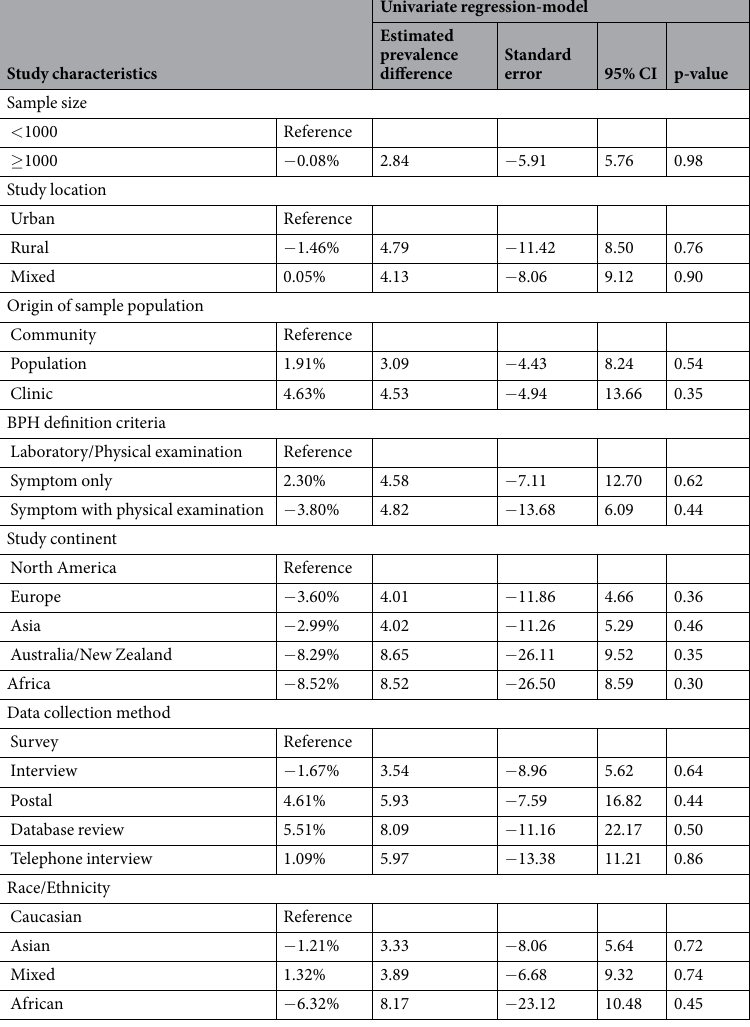
Table 2. Association between study variables and BPH prevalence